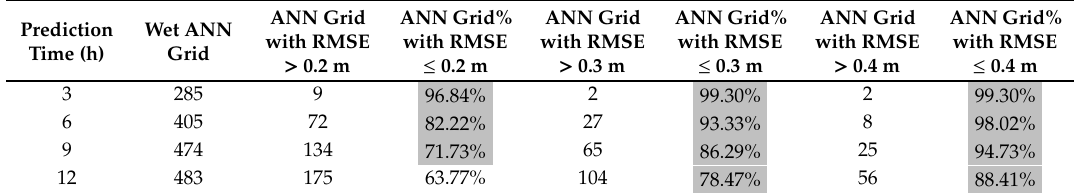
Note: highlighted in gray are the percentages larger than 70%.